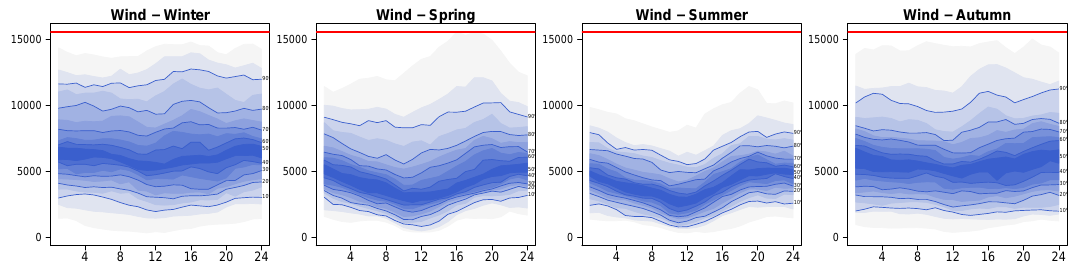
Figure 4. The wind generation seasonal pattern for 2017. Source: authors based on the data from REE